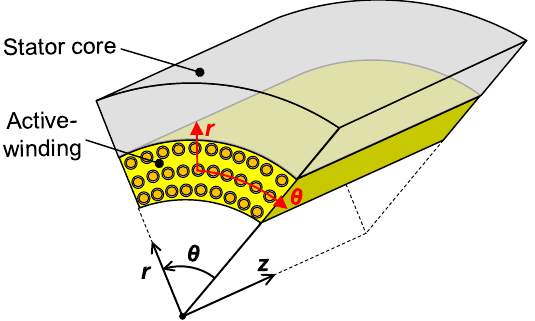
Figure 31. Active-winding modelling in cylindrical coordinates.